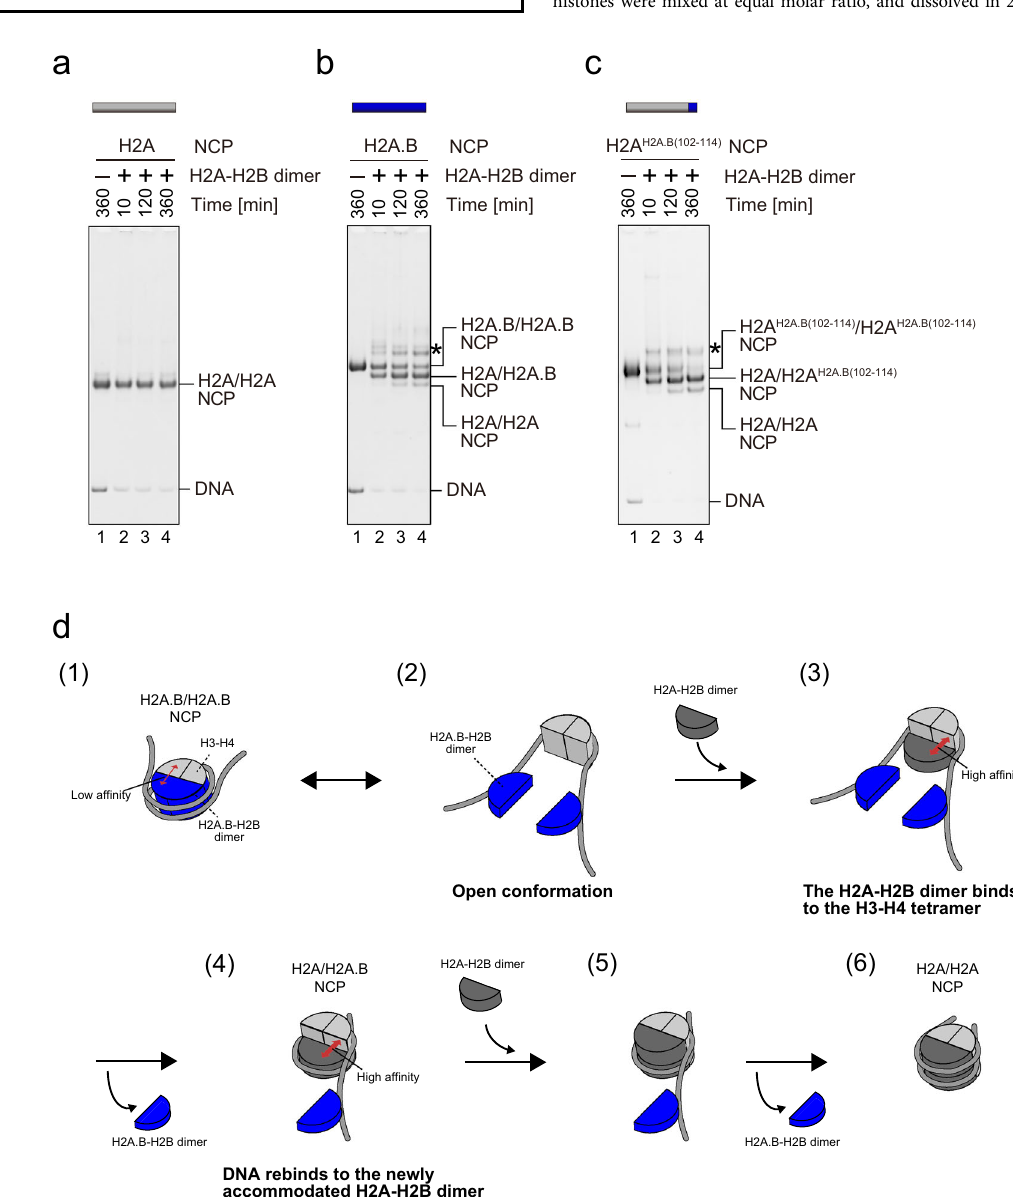
Fig. 6 Histone exchange activity of the H2A H2A.B(102 – 114) NCP. a – c Representative gel images of the histone exchange assays of the H2A ( a ), H2A.B ( b ), and H2A H2A.B(102 – 114) ( c ) NCPs. The NCPs (1 µ M) were incubated with the H2A-H2B dimer (0 µ M: lane 1; 2 µ M: lanes 2, 3, and 4) for 10 min (lane 2), 120 min (lane 3), and 360 min (lanes 1 and 4). After the incubation, the samples were analyzed by native-PAGE with ethidium bromide staining. The asterisk indicates the NCP-histone complexes. Reproducibility is con fi rmed by three independent experiments, and the results are presented in Supplementary Fig. 8. The uncropped gel images are shown in Supplementary Fig. 9. d Model showing the spontaneous exchange of the H2A.B-H2B dimer with the canonical H2A-H2B dimer in the H2A.B NCP. When the H2A.B NCP forms an open conformation (2), the H2A-H2B dimer (dark gray) preferably binds to the H3-H4 tetramer (light gray) because of its higher af fi nity to the H3-H4 tetramer (3). The DNA rebinds with the newly accommodated H2A- H2B dimer (4). Another H2A-H2B dimer then binds to the NCP (5), and the remaining H2A.B-H2B dimer (blue) dissociates from the DNA